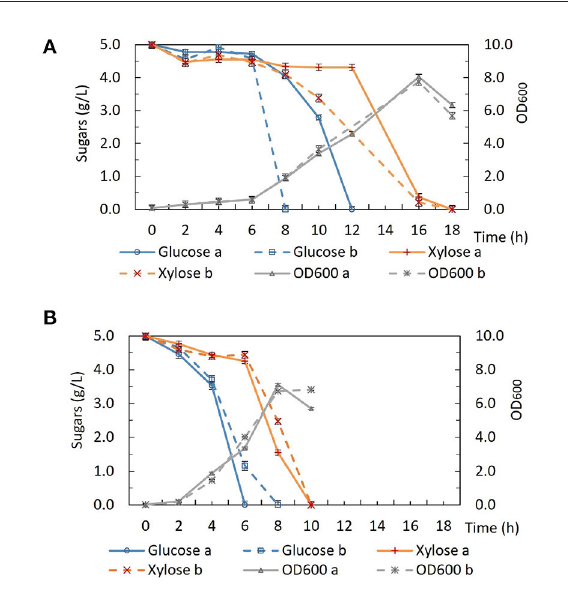
FIGURE2 Growth and sugar consumption profile of (A) P. thermoglucosidasius DSM 2542 and (B) P. thermoglucosidasius DSM 2542 pstH1 in ASM medium supplemented with 1% (w/v) glucose and 1% (w/v) xylose under fermentative conditions in a bioreactor. Error bars are ± standard deviation of three replicates taken at the same time point.